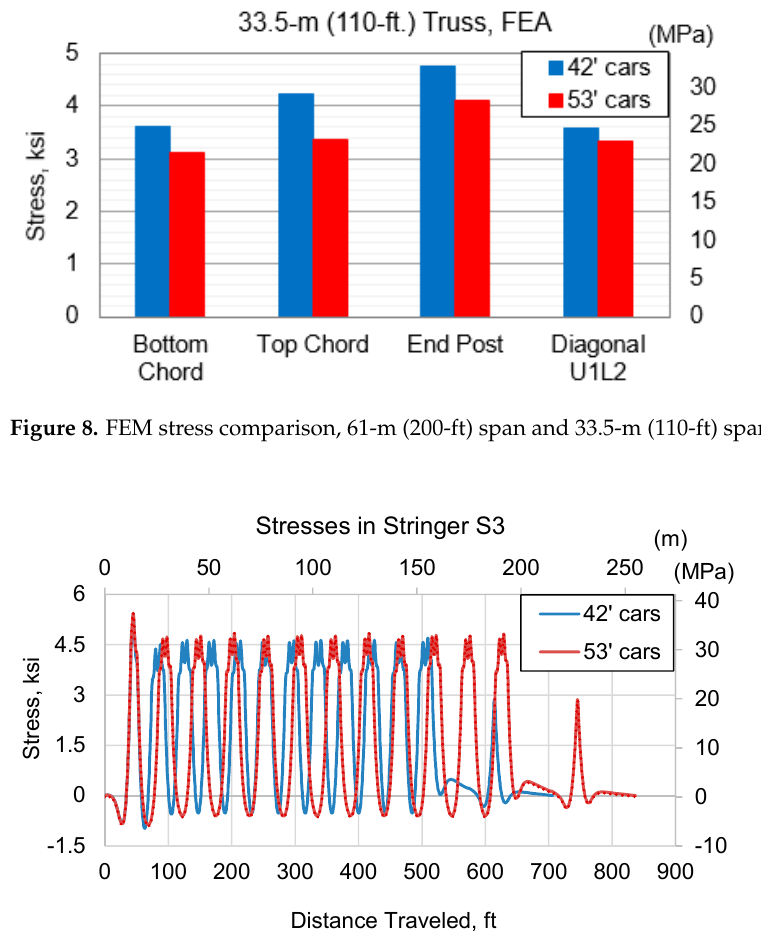
Figure 9. FEM stress comparison, 61-m (200-ft) span and 33.5-m (110-ft) span. The stress ranges due to 12.8-m (42-ft) short railcars and 16.2-m (53-ft) standard length railcars were predicted to be less than 6.9 MPa (1.0 ksi) for all primary members in both trusses. Higher stress ranges, up to 13.8 MPa (2.0 ksi), were predicted on secondary diagonals due to 16.2-m (53-ft) railcars. As expected, the largest stress ranges were seen on stringers, as noted above.